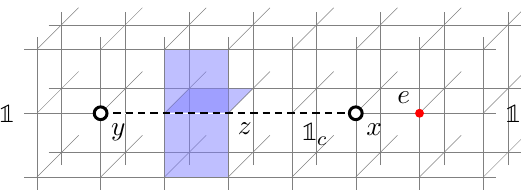
Figure 24. The topological defects on the smooth boundary.